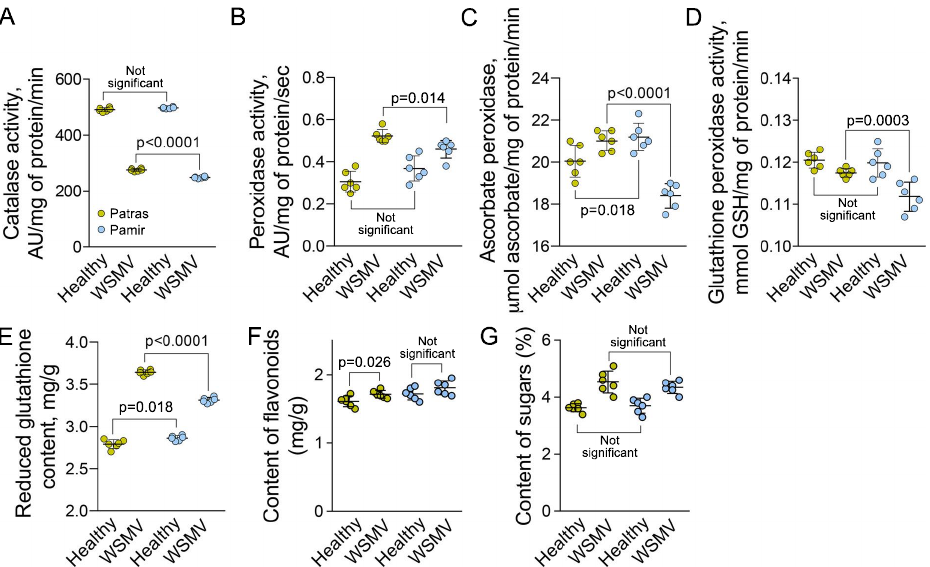
Figure 5. Response of ROS scavenging system to WSMV infection. ( A – D ), Activity of catalase ( A ); peroxidase ( B ); ascorbate peroxidase ( C ); and glutathione peroxidase ( D ) in leaves of healthy or WSMV-infected plants. ( E , F ), Content of reduced glutathione ( E ) and flavonoids ( F ) per one gram of leaf fresh weight from healthy or WSMV-infected plants. G , Content of soluble sugars (mono- saccharides and oligosaccharides) in leaves of healthy or WSMV-infected plants. Six biological replicates (individual plants) were measured per each treatment. p values were calculated using non-paired t -test.